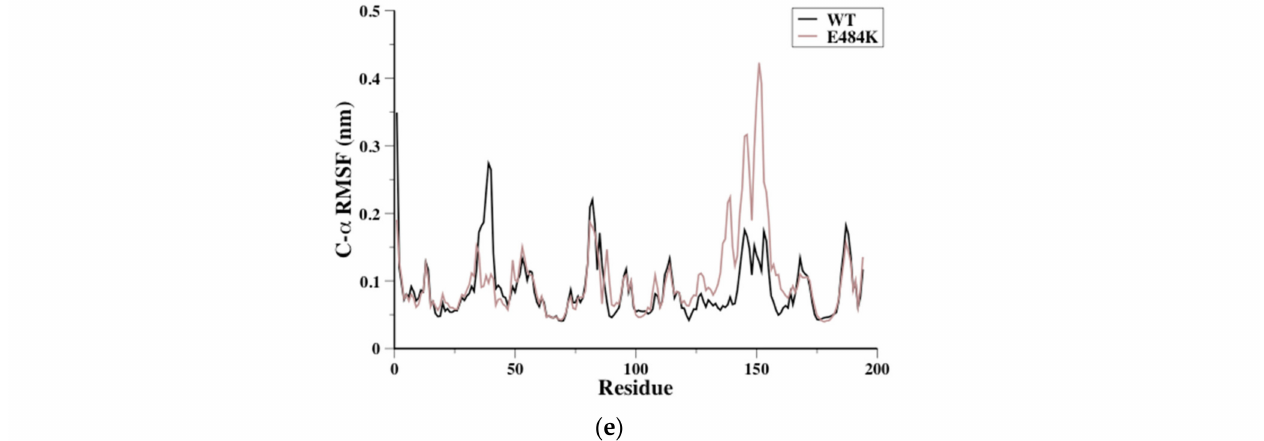
Figure 2. The C- α root mean square fluctuation (C- α RMSF) in nm for WT RBD aligned with either N501Y ( a ), L452R ( c ), S477N ( d ), N439K ( e ), or E484K ( f ) RBDs as a function of RBD residues obtained from the 100-ns MD simulations. The WT RBD cartoon representative ( b ) was plotted to indicate the RBD regions of